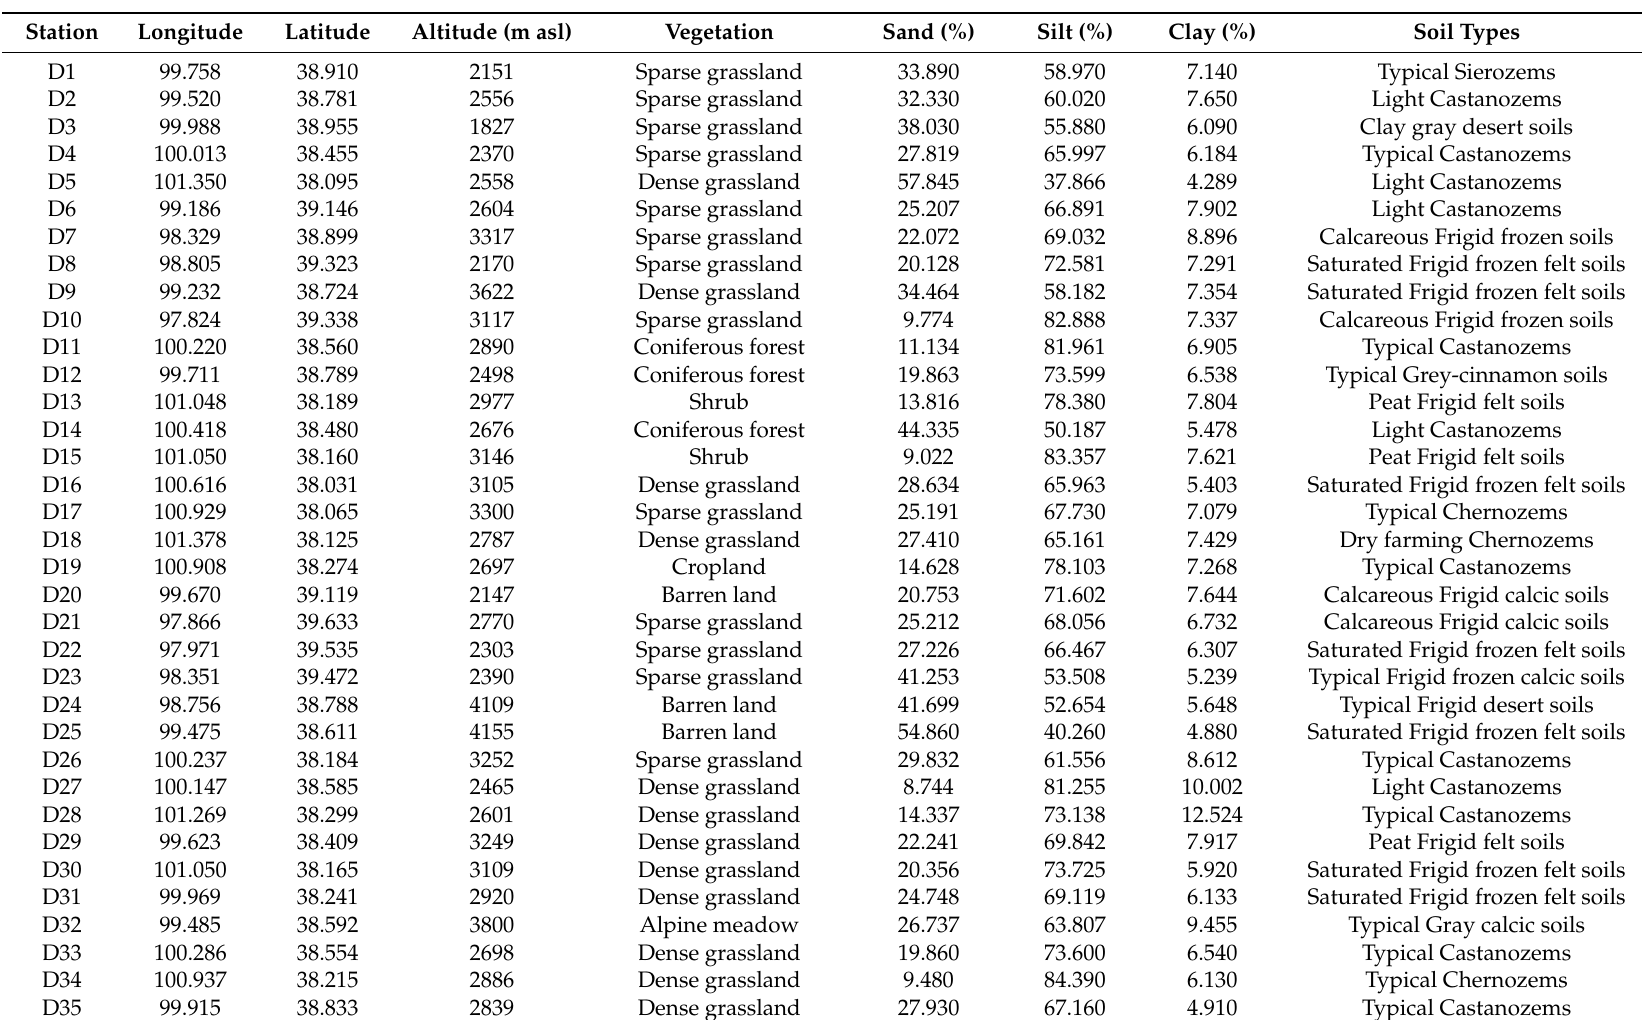
Table 1. The in-situ observation points in the study